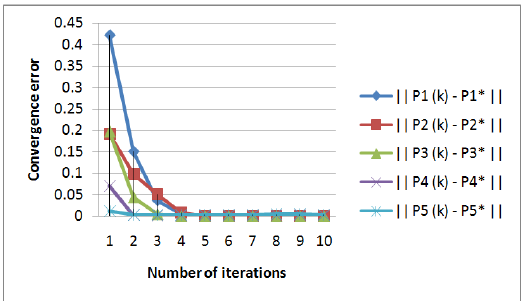
P to * P during learning i i iterations.